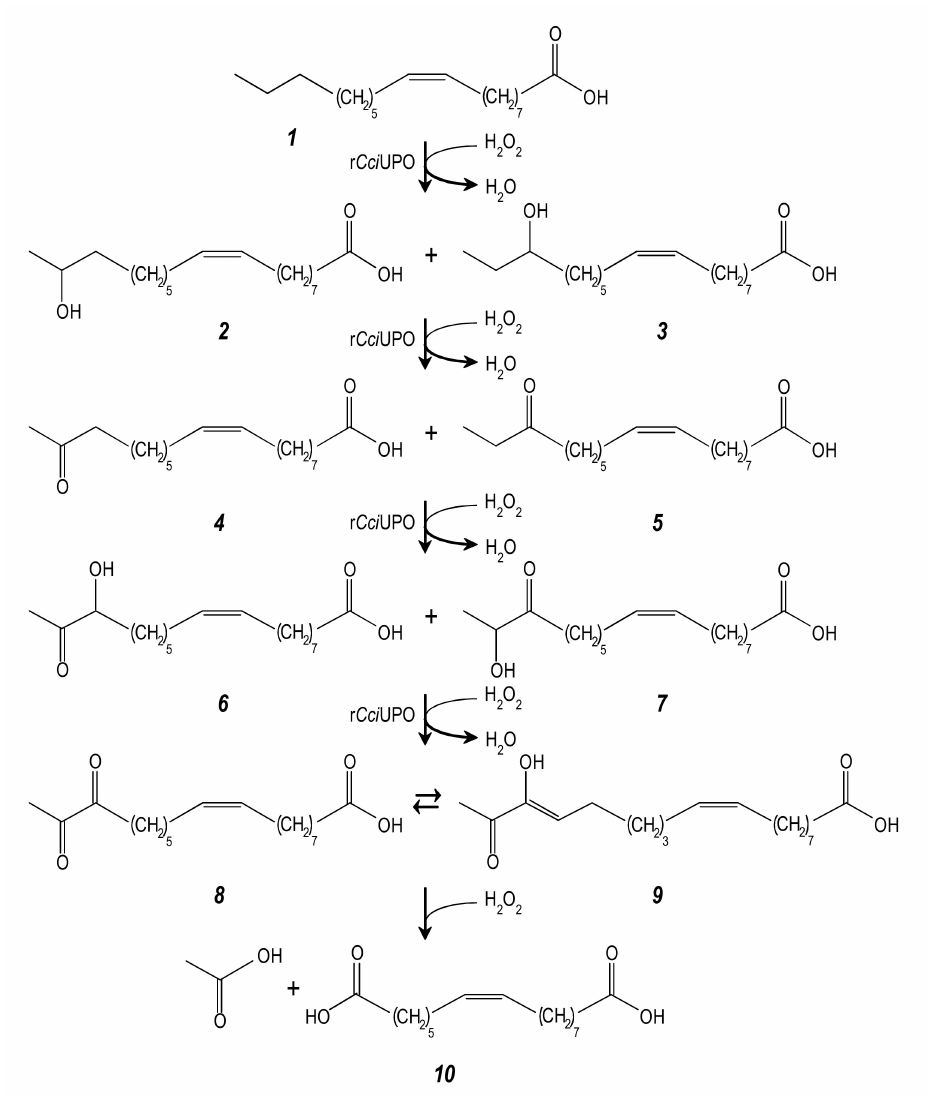
Figure 3. Proposed pathway for the 2C-shortening of fatty acids by UPOs (and their H 2 O 2 cosub- strate) showing the structures of oleic acid ( 1 ), its monohydroxylated derivatives at ω -1 ( 2 ) and ω -2 ( 3 ) positions, the mono-keto derivatives at ω -1 ( 4 ) and ω -2 ( 5 ) positions, the dioxygenated hydroxy- keto ( 6 ) and keto-hydroxy ( 7 ) derivatives, the di-keto ( 8 ), in equilibrium with its keto-enol isomer ( 9 ) derivatives, and finally the 2C shortened dicarboxylic acid ( 10 ) from H 2 O 2 cleavage of the diketo C-C